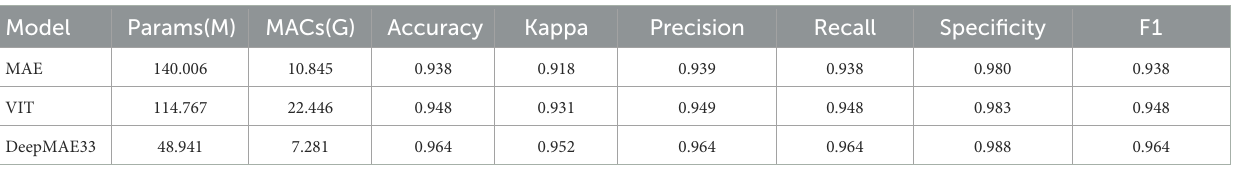
TABLE 6 The evaluation of three